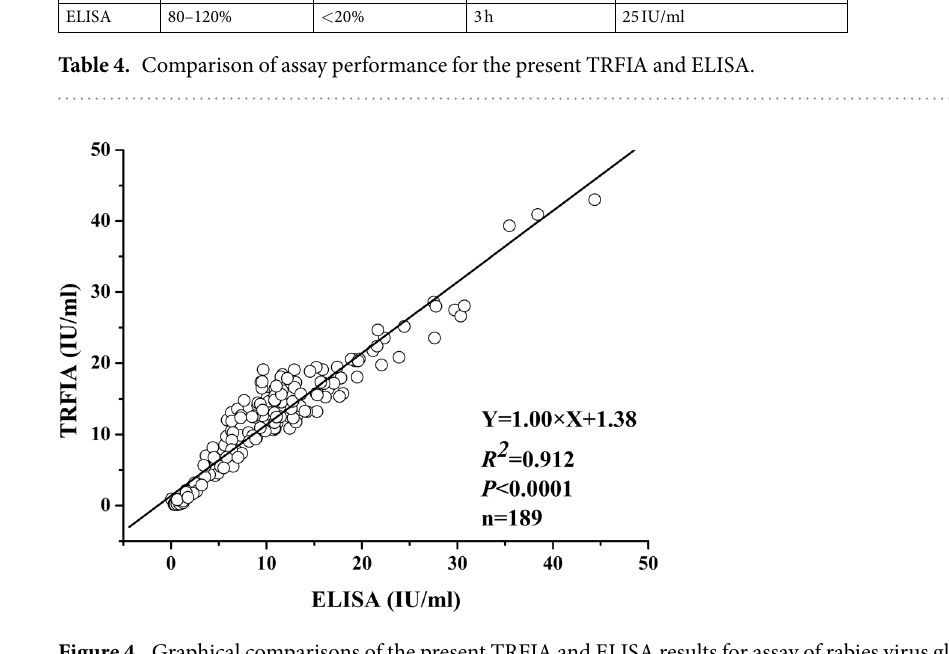
Figure 4. Graphical comparisons of the present TRFIA and ELISA results for assay of rabies virus glycoprotein.